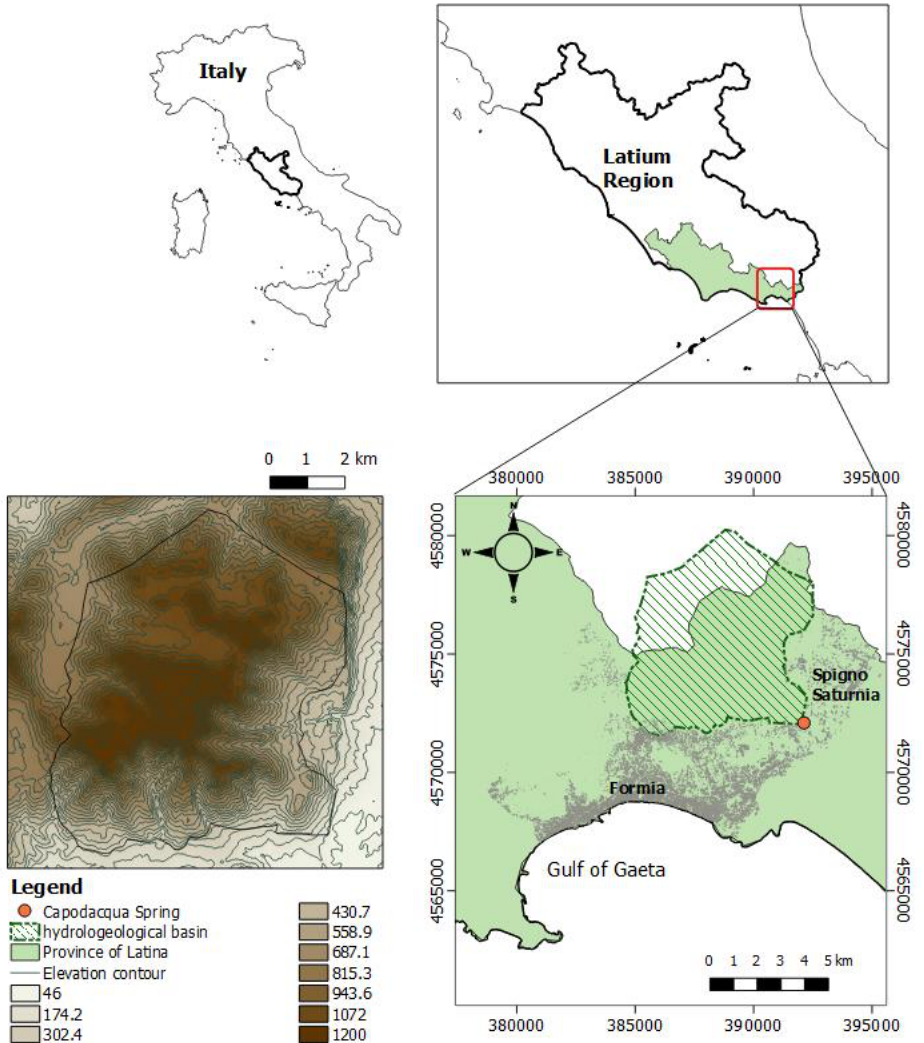
Figure 1. Territorial framework (WGS84 coordinates in meters).